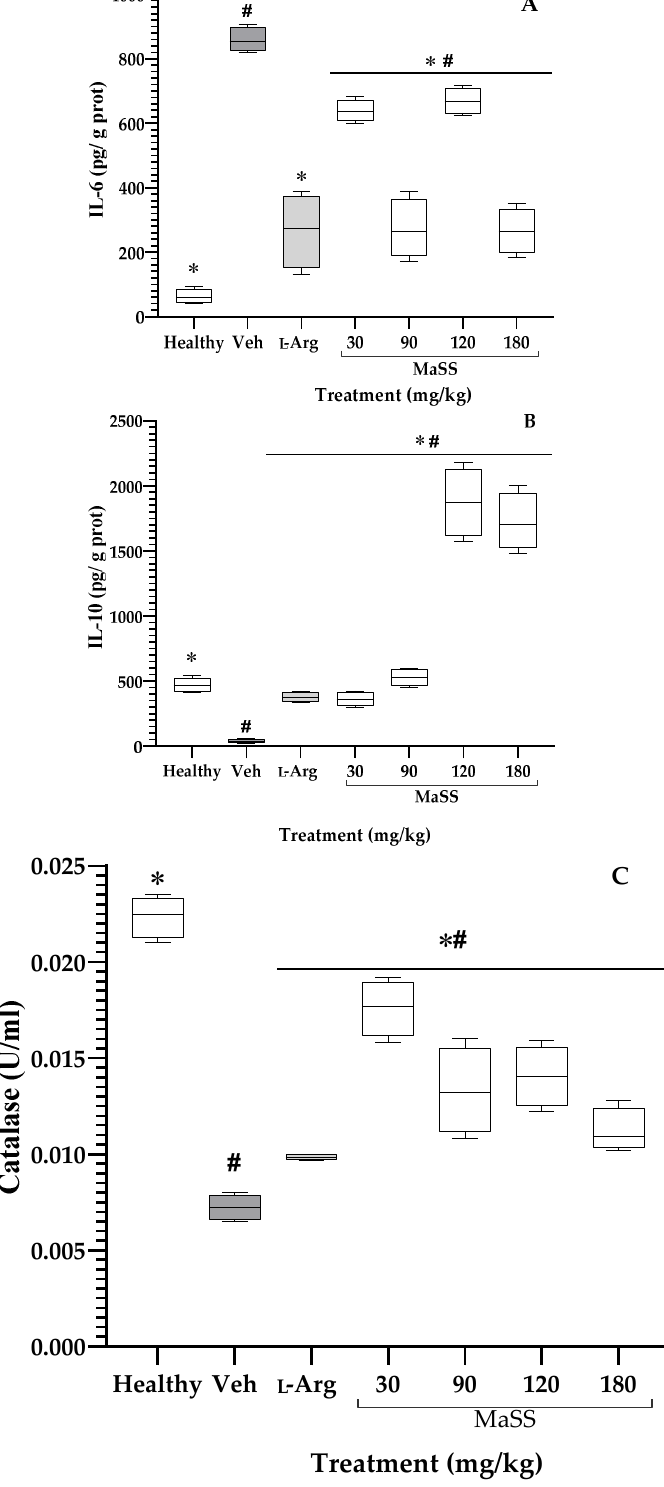
Figure 7. Effect of different doses of MaSS, mixture of kaempferol 3- O -sophoroside and kaempferol 3- O -sambubioside, obtained from M. arboreus , on the gastric concentration of interleukin-10 (IL-10, A ) and 6 (IL-6, B ), and enzyme activity (catalase, C ), in Sprague Dawley rats, with ethanol-induced ulcers. Healthy = rats without gastric ulcers; L-Arg = L-arginine. ANOVA post-Tukey’s test with (n = 5, x ± ED, # p < 0.05 when groups are compared with the healthy group; * p < 0.05 compared with the Veh